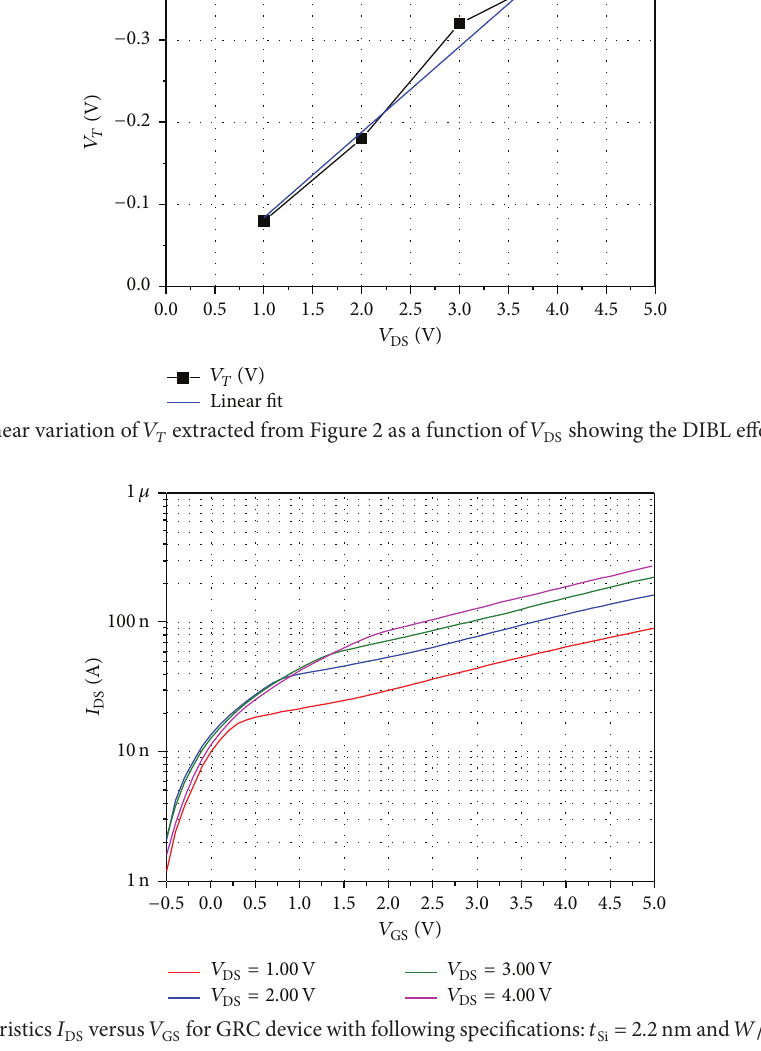
is suppressed by lowering the temperature. It turns also